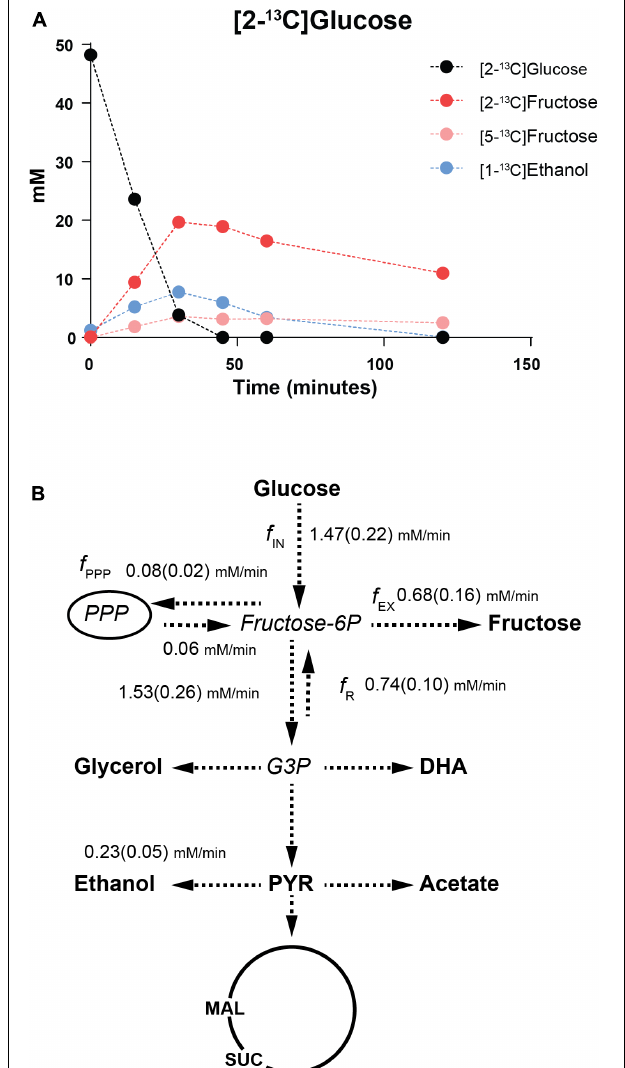
FIGURE 3 | 13 C-NMR analyses of [2- 13 C]glucose metabolism in St. bombicola mtdh1 (cid:49) mtdh2 (cid:49) mutant. (A) Time course of 13 C-labeled glucose consumption and product formation by resting cell suspensions of the St. bombicola mtdh1 (cid:49) mtdh2 (cid:49) mutant. End products were quantified by 13 C-NMR in supernatants after a pulse (at time zero) of [2- 13 C]glucose to a final concentration of approximately 50 mM. A comprehensive list of labeled end-product concentrations for this and similar assays is shown in Supplementary Table S3 . (B) Metabolic fluxes deduced from experiments with 13 C-labeled glucose. Observed metabolites are shown in bold (DHA: dihydroxyacetone; PYR: pyruvate; MAL: malate; SUC: succinate) and inferred intermediates in italic (G3P: glyceraldehyde-3-phosphate). PPP represents the reactions of the pentose phosphate pathway. Each conversion, shown by dashed lines, may involve multiple steps. Standard deviations are shown in